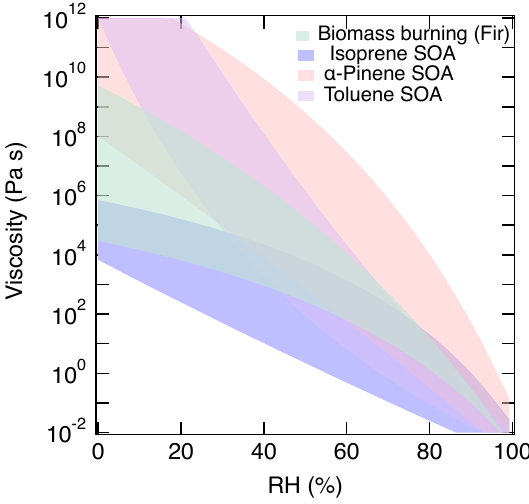
Figure 10. Summary of the predicted range of viscosity for α - pinene SOA (red), isoprene SOA (blue), toluene SOA (purple), and biomass burning particles